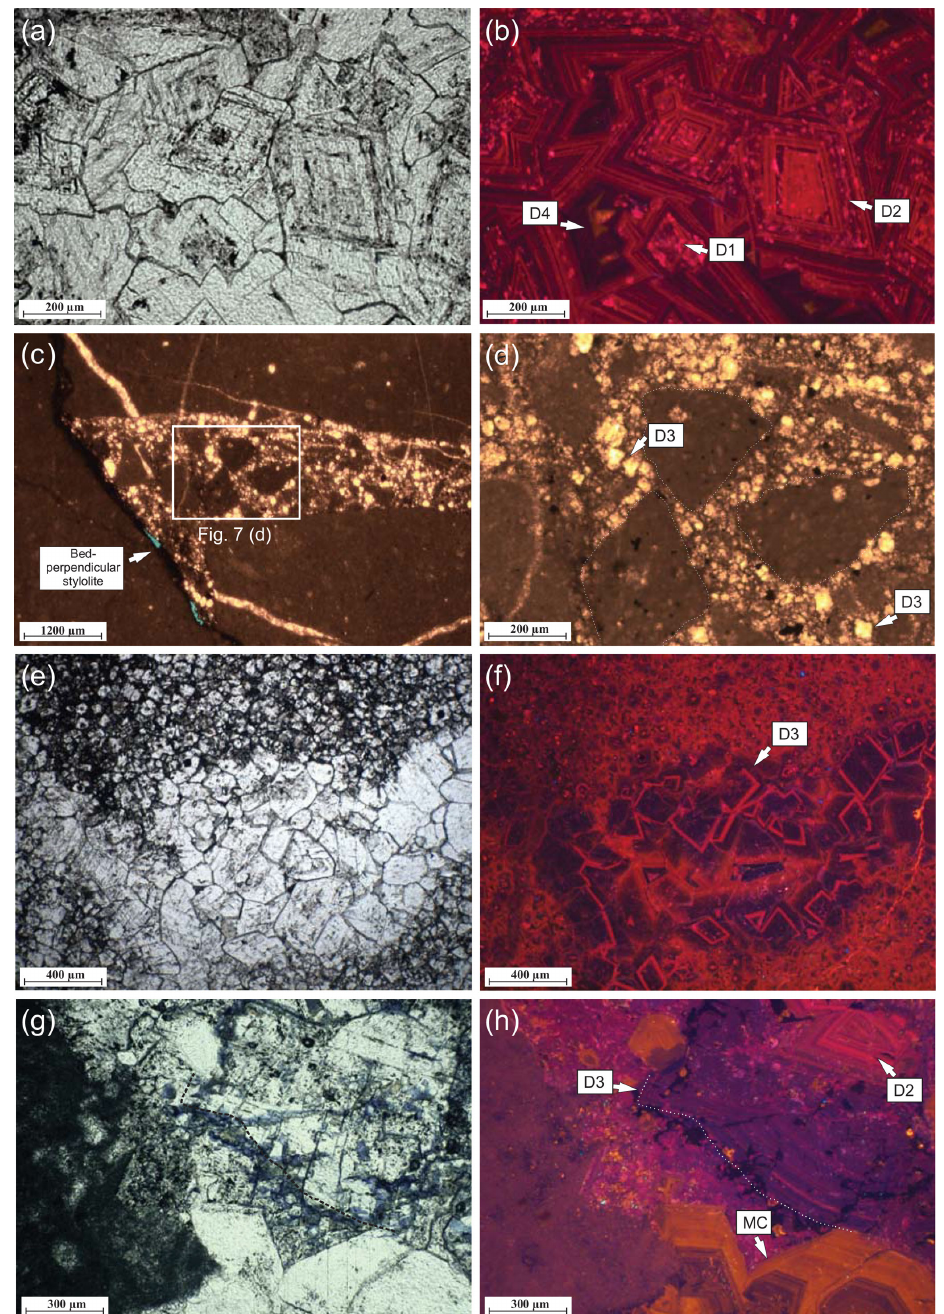
Figure 7. (a, b) Photomicrographs of transmitted light and corresponding cathodoluminescence image, respectively, showing the zoned rhombs of D2 with the remnants of D1 preserved in their cloudy core sampled from dolomitized Calcare Massiccio Formation in field site d. The pore space is occluded by D4. (c, d) D3 cementing angular breccia fragments of the Bugarone Formation in the damage zone of the Montagna dei Fiori Fault in the Corano Quarry site. Note the breccia is overprinted by a fault-parallel bed-perpendicular stylolite. (e, f) Photomicrographs of transmitted light and corresponding cathodoluminescence image, respectively, showing the euhedral to subhedral crystals of D3 entirely replacing the matrix and also present as cement developing a bright subzone and rim sampled from dolomitized Corniola Formation in Osso Caprino road. (g, h) D3 with a saddle crystal outline (SD) postdating calcite cements (MC) and a zoned D2 crystal. The saddle morphology is outlined by a dotted white